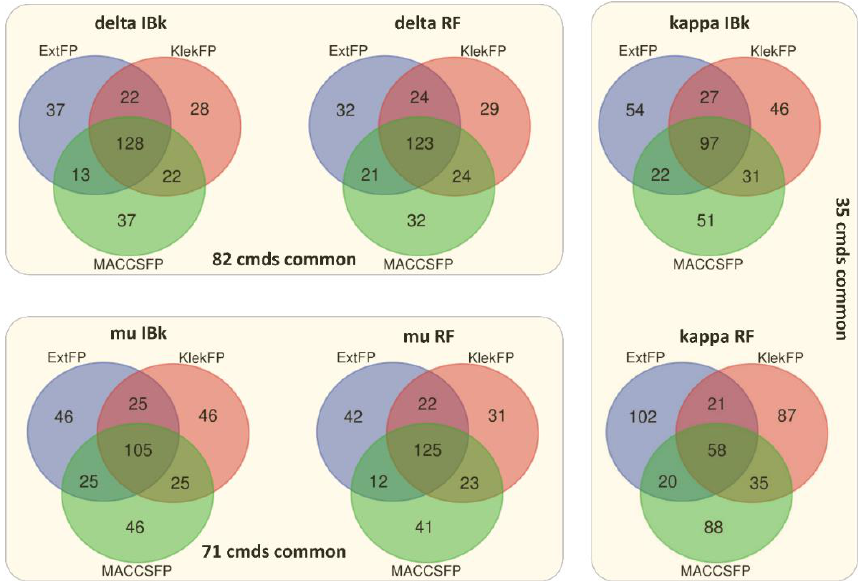
Figure 4. Overlap of the top 200 compounds with the highest prediction error.